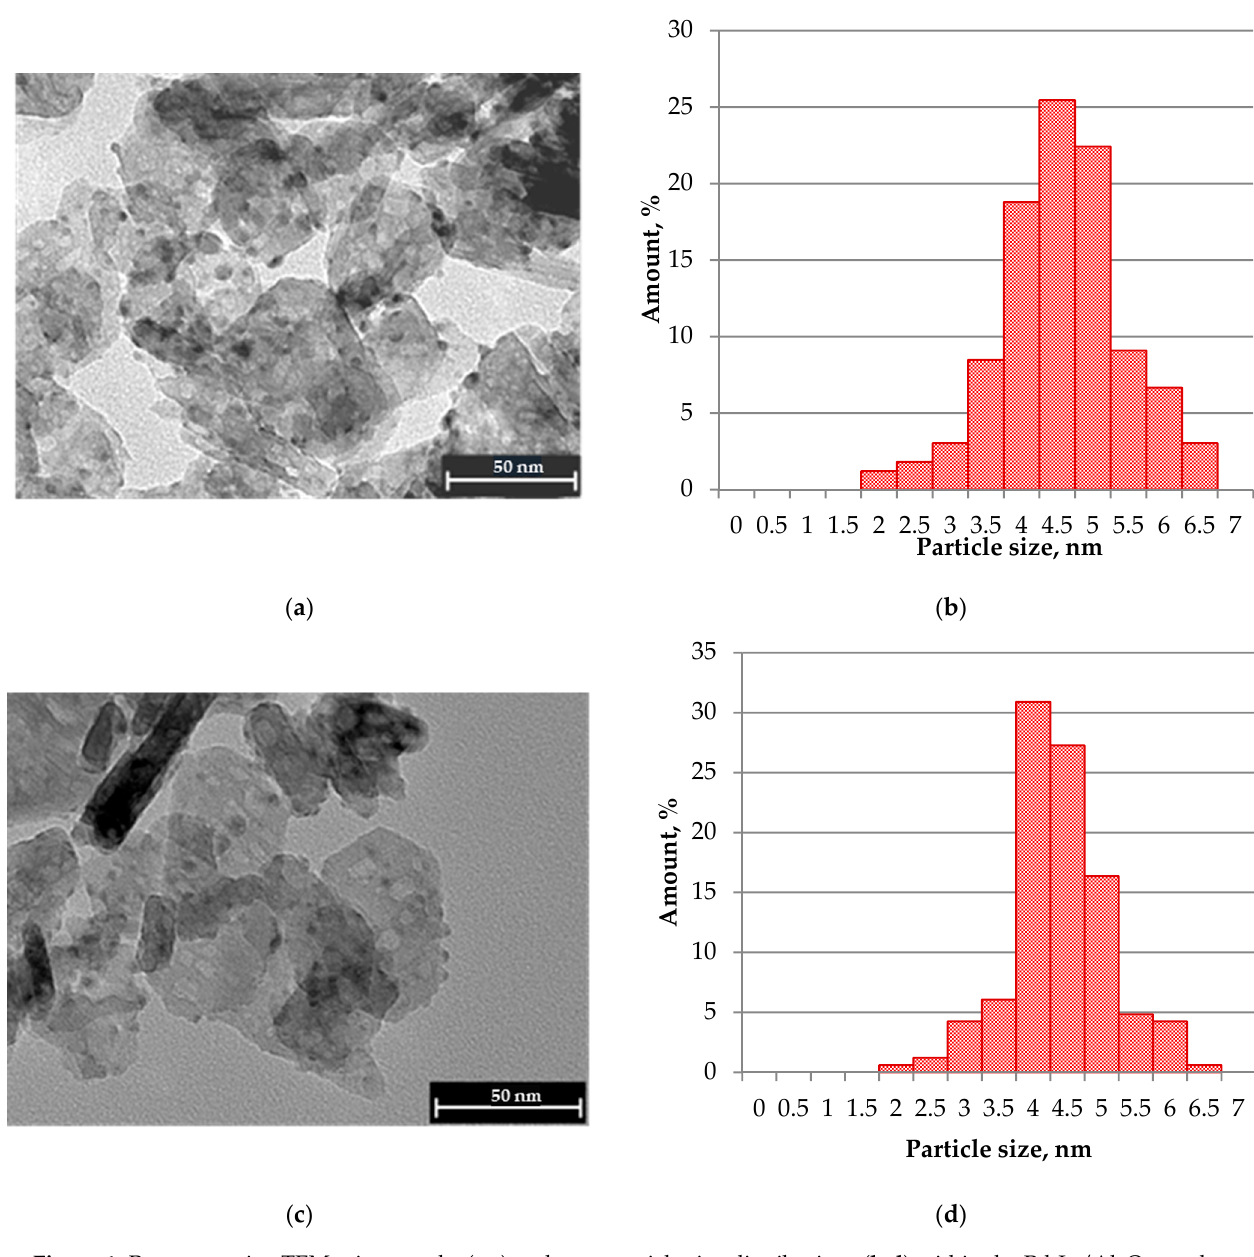
Figure 1. Representative TEM micrographs ( a,c ) and nanoparticle size distributions ( b,d ) within the Pd-In/Al 2 O 3 catalyst before ( a,b ) and after ( c,d ) the in situ oxidative treatment.